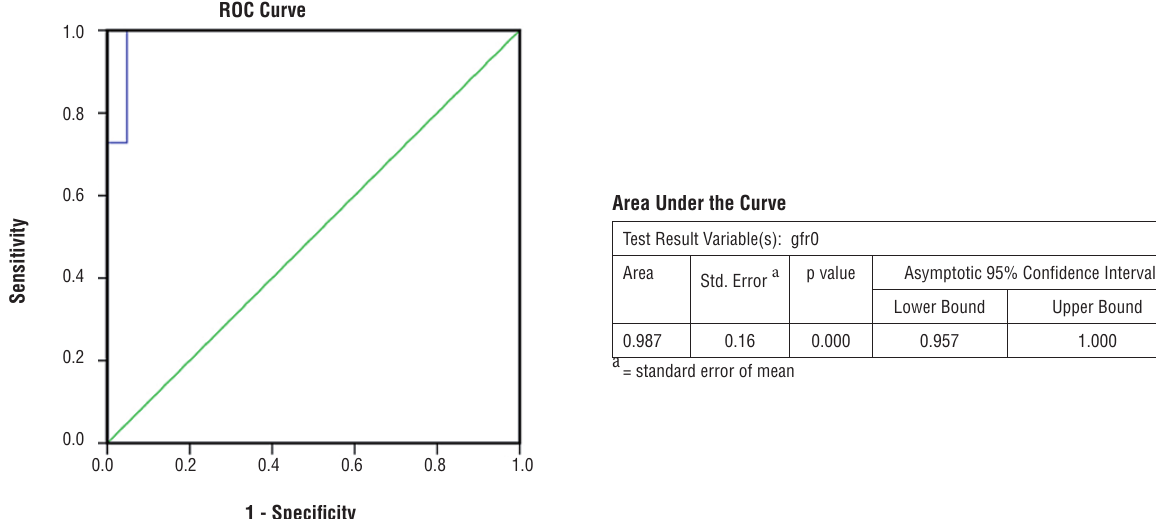
Figure 2 - Receiver Operator Curve of Baseline e-GFR For Augmentation